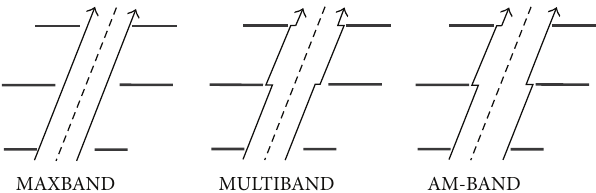
Figure 1: Time-space diagram of MAXBAND, MULTIBAND, and